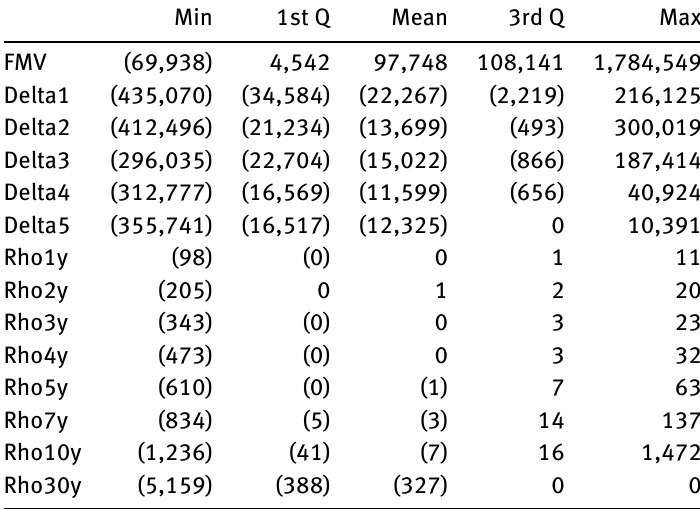
Table 10: Summary statistics of the fair market values and greeks of individual policies. Numbers in parenthesis are negative